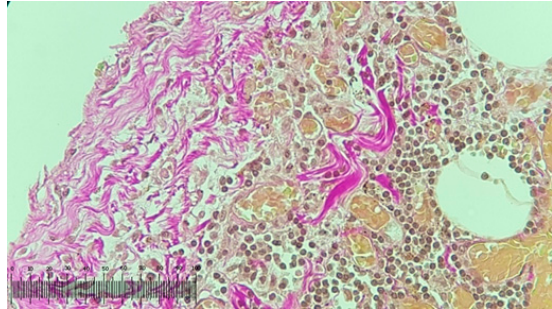
Figure 14. Inflammatory infiltration with diffuse lympho-monocytes and macrophages, 7 days after ischemia.